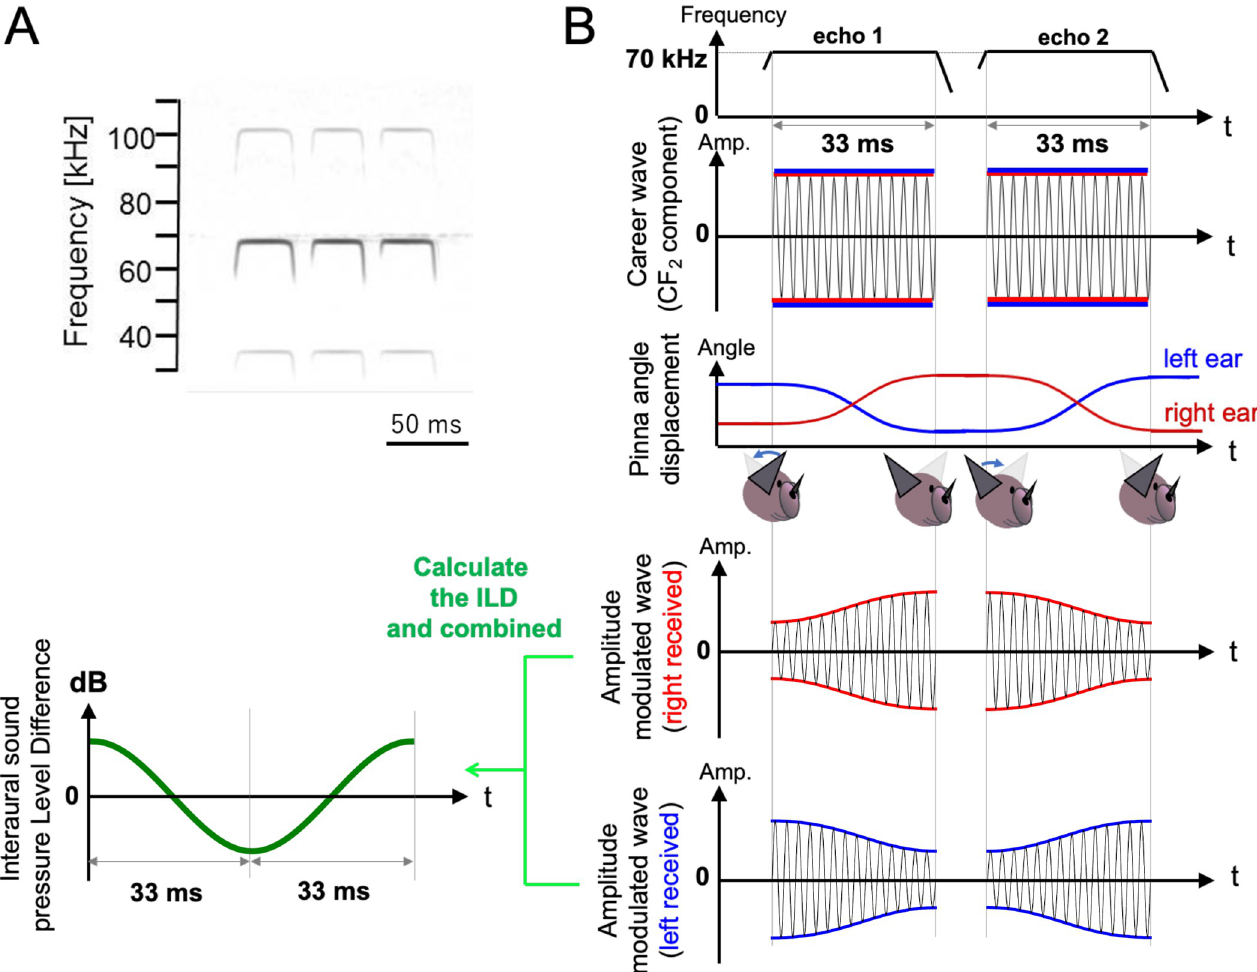
Fig 1. Pulse emission and reflective echo patterns of the simulation. (A) Typical time–frequency structure of the echolocation pulse emitted by Rhinolophus ferrumequinum Nippon . (B) Schematic diagram of amplitude modulation of CF 2 component in the simulated echo caused by virtual pinnae motions. In this example simulation, the left and right ear movements were assumed to exhibit anti-phase motions in pitch angle over ± 15˚. The hearing axis in the right ear rotates down-forward and then up-backward, while that in the left ear rotates in the inverse direction. The amplitude-modulated echo was simulated by assuming the object has an elevation angle of 30˚.